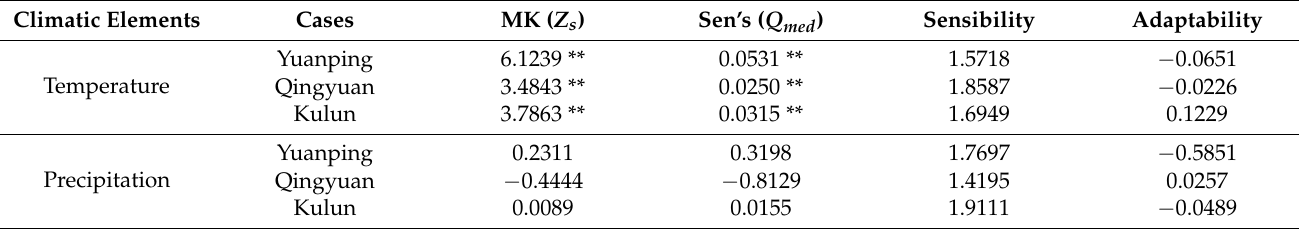
Table 2. Change trend tests and vulnerability assessment in climate elements.